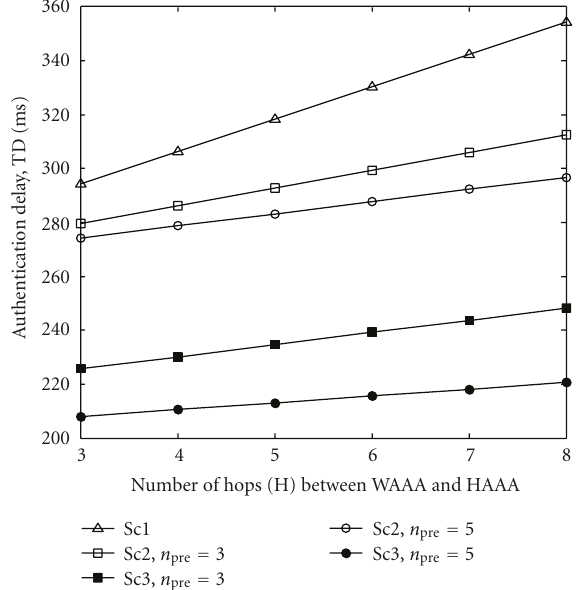
Figure 9: Authentication delay in Sc1, Sc2, and Sc3 when varying H WAAA-HAAA . Table 1: Number of keys generated in the three authentication scenarios. Sc1 Sc2 =